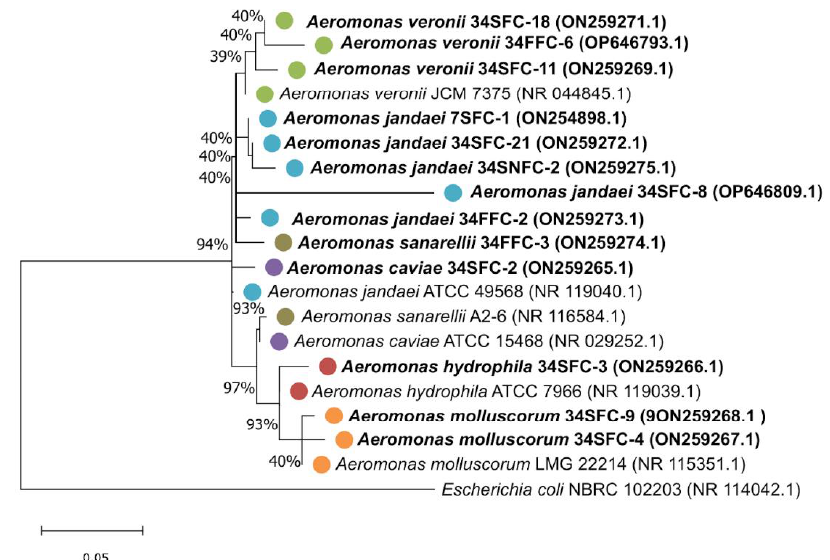
Figure 1. Maximum likelihood (ML) phylogenetic tree based on the 16S rRNA of Aeromonas spp. isolated from GB waters (in bold) and from reference sequences downloaded from NCBI. The colored dots represent different species, and the accession numbers are also depicted. Brown: A. sanarellii ; purple: A. caviae ; blue: A. jandaei ; green: A. veronii ; red: A. hydrophila , and orange A. molluscorum . Escherichia coli strain NRBC 102203 was used as an outgroup. 2.2. Detection of intI1, Antimicrobial and Heavy Metal Resistance Genes Antimicrobial-resistant strains were further characterized to assess the presence of class 1 integron-integrase, and antimicrobial and heavy metal resistance genes. Among these, six (46.1%) were bla TEM positive. The second most frequently detected gene was bla KPC , identified in four (30.7%) strains. The mcr-3 gene was detected in two (15.4%) and the intI1 gene was detected in seven (53.8%) of the tested strains (Figure 2). On the other hand, merA , coding for mercury resistance, was the most often detected HMRG (10, 76.9%) and, out of a total of 11 strains positive for at least one HMRG, six (54.5%) strains also carried at least one ARG. The previously performed phenotypic antimicrobial susceptibility test results [8] are also shown in Figure 2. For the detection of heavy metal resistance, we relied on PCR assays, a more direct and eco-friendly approach.